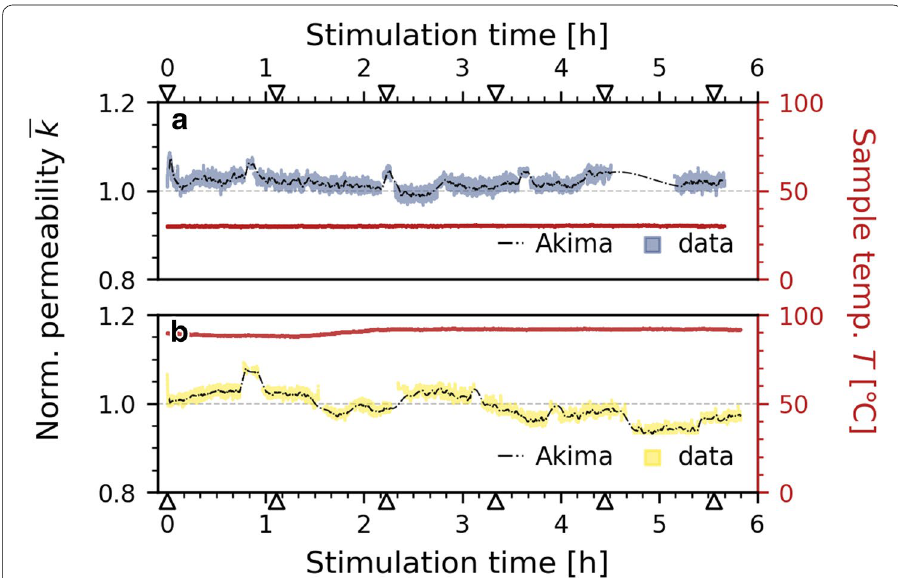
Fig. 8 Evolution of sample permeability during acid flow-through experiments. a Sample G2M-A5, subject to approximately 6 h of stimulation with 0.2-M HCl solution, at a sample temperature of 30 ◦ C . Triangles indicate times whereat aliquots of effluent acid solution were sampled for further analysis. Normalised data are shown in colour, and dash–dot line is an Akima spline function used to interpolate missing data. b Sample G2M-A6, subject to approximately 6 h of stimulation with 0.2-M HCl solution, at a sample temperature of 100 ◦ C . Triangles indicate times whereat aliquots of effluent acid solution were sampled for further analysis. Normalised data are shown in colour, and dash–dot line is an Akima spline function used to interpolate missing data. Note that only the acid flow-through portion of the experiments are shown: the pre- and post-stimulation stages using deionised H 2 O are omitted for